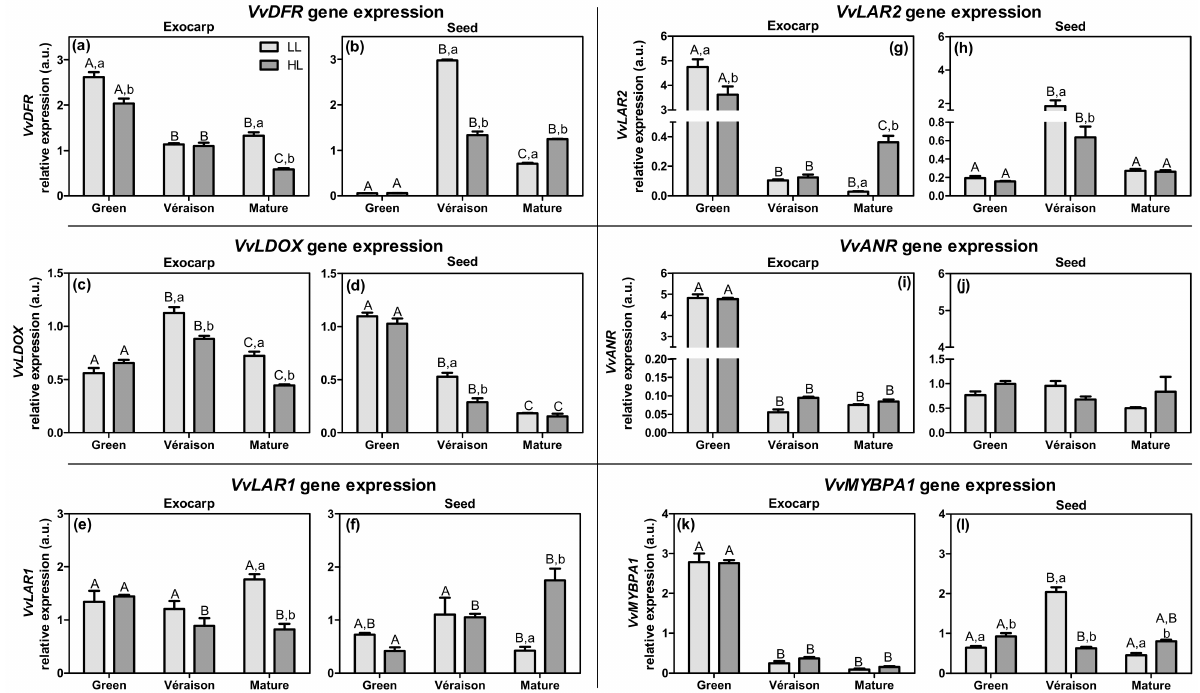
Figure 7. Relative expression in arbitrary units (a.u.) of transcripts of dihydroflavonol reductase ( VvDFR ) ( a , b ), leu- coanthocyanidin dioxygenase ( VvLDOX ) ( c , d ), leucoanthocyanidin reductase 1 and 2 ( VvLAR1 and VvLAR2 ) ( e – h ), and anthocyanidin reductase ( VvANR ) gene ( i , j ), and of transcription factor MYBPA1 ( VvMYBPA1 ) ( k , l ) in exocarp and seeds, from berries grown at two distinct light microclimates (LL and HL), and at three developmental stages (green, v é raison , and mature), as determined by real-time qPCR. Expression levels are normalized to the mean expression of reference genes VvACT1 and VvGAPDH . Statistical analysis (two-way ANOVA, p ≤ 0.05, n = 3) was applied after data Log(X+1) transforma- tion. Statistical notation: capital letters refer to differences between developmental stages for the same microclimate, and lowercase letters refer to differences between microclimates for each stage. When the letters are omitted, it means that the respective factor did not have a significant